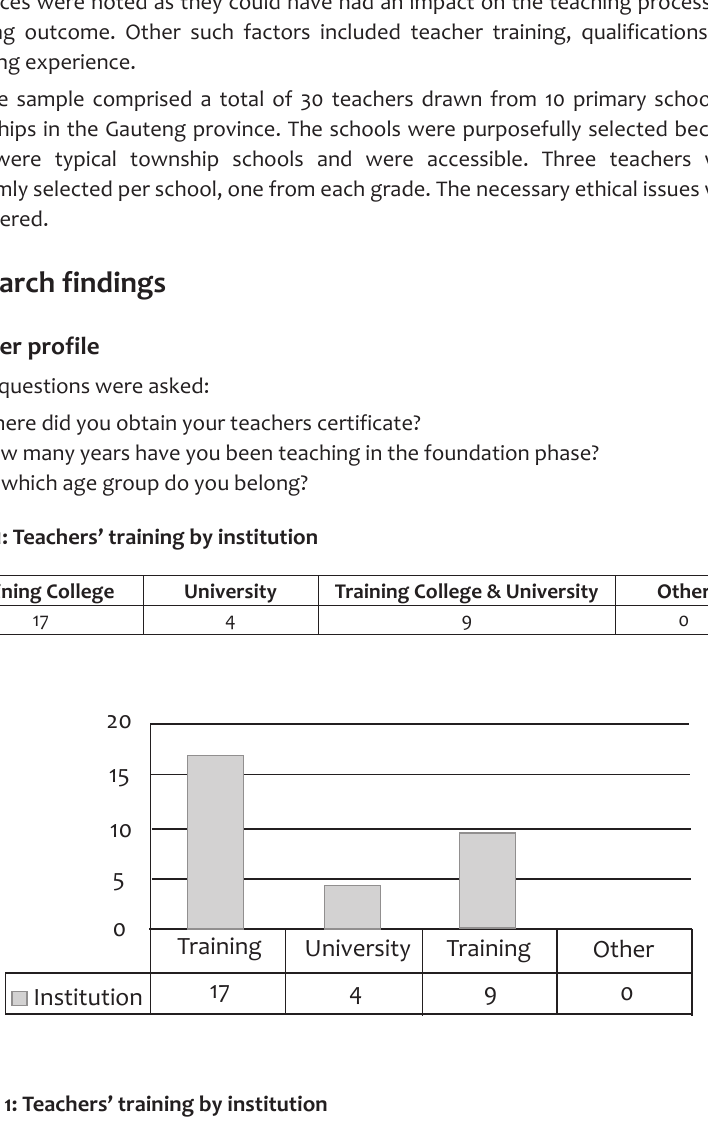
Figure 1: Teachers’ training by